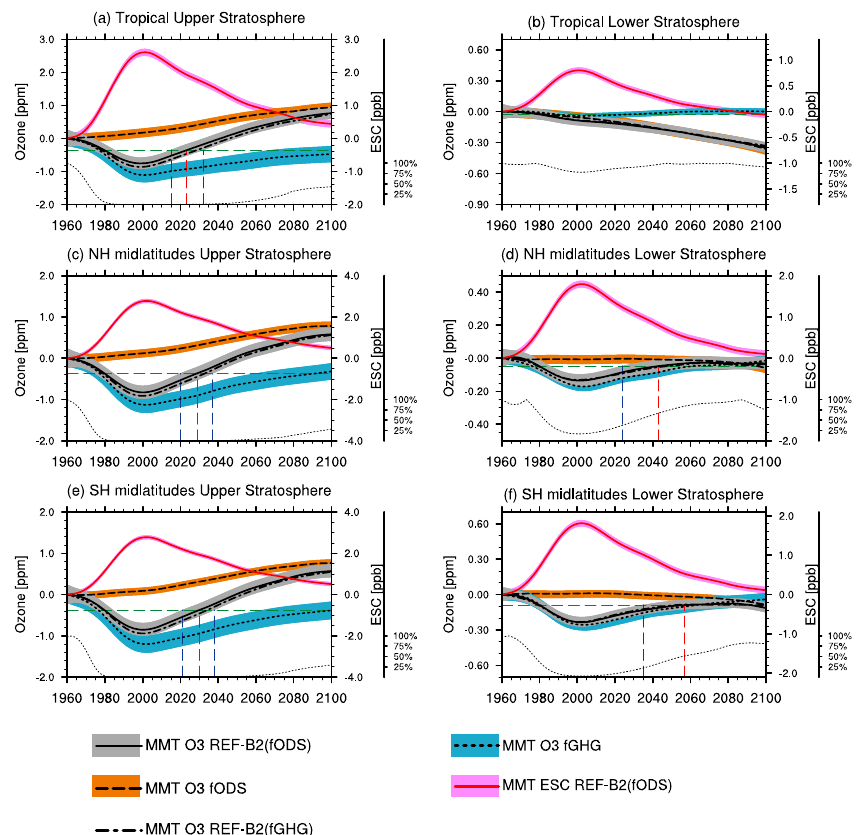
Fig. 2. Extra-polar, annual mean 1960 baseline-adjusted ozone projections and 95% confidence interval for the multi-model trend (MMT) of REF-B2 which is derived from the models that performed the fODS simulation ( MMT O3 REF-B2(fODS) ; black line and grey shaded area) and from the models that performed the fGHG simulation ( MMT O3 REF-B2(fGHG) ; black dashed-dotted line). Also shown is the multi-model trend plus 95% confidence interval for fODS (black dotted line and orange shaded area), fGHG (black dashed line and blue shaded area), and ESC ( MMT ESC REF-B2(fODS) displayed with red solid line and light red shaded area). The different panels show (a) 5hPa and (b) 50hPa tropics (25 ◦ S–25 ◦ N), (c) 5hPa and (d) 50hPa northern midlatitudes (35 ◦ N–60 ◦ N), (e) 5hPa and (f) 50hPa southern midlatitudes (35 ◦ S–60 ◦ S). The multi-model mean for REF-B2, fODS, and ESC is formed from 9 CCMs (CCSRNIES, CMAM, GEOSCCM, LMDZrepro, MRI, SOCOL, UMSLIMCAT, ULAQ, and WACCM) and the one for fGHG from 7 CCMs (CCSRNIES, CMAM, EMAC-FUB, E39CA, MRI, ULAQ, and WACCM). The red vertical dashed line indicates the year when the multi-model mean of the 9 CCMs in REF-B2 returns to 1980 values (green horizontal dashed line) and the blue vertical dashed lines indicate the uncertainty in these return dates. The thin dotted black line in the bottom of each panel shows the results of the t-test’s confidence level that the multi-model means from fODS and REF-B2 are from the same population (see Sect. 5 for details).The individual models are shown in figures in the supplementary material. Note the differing Y-axis